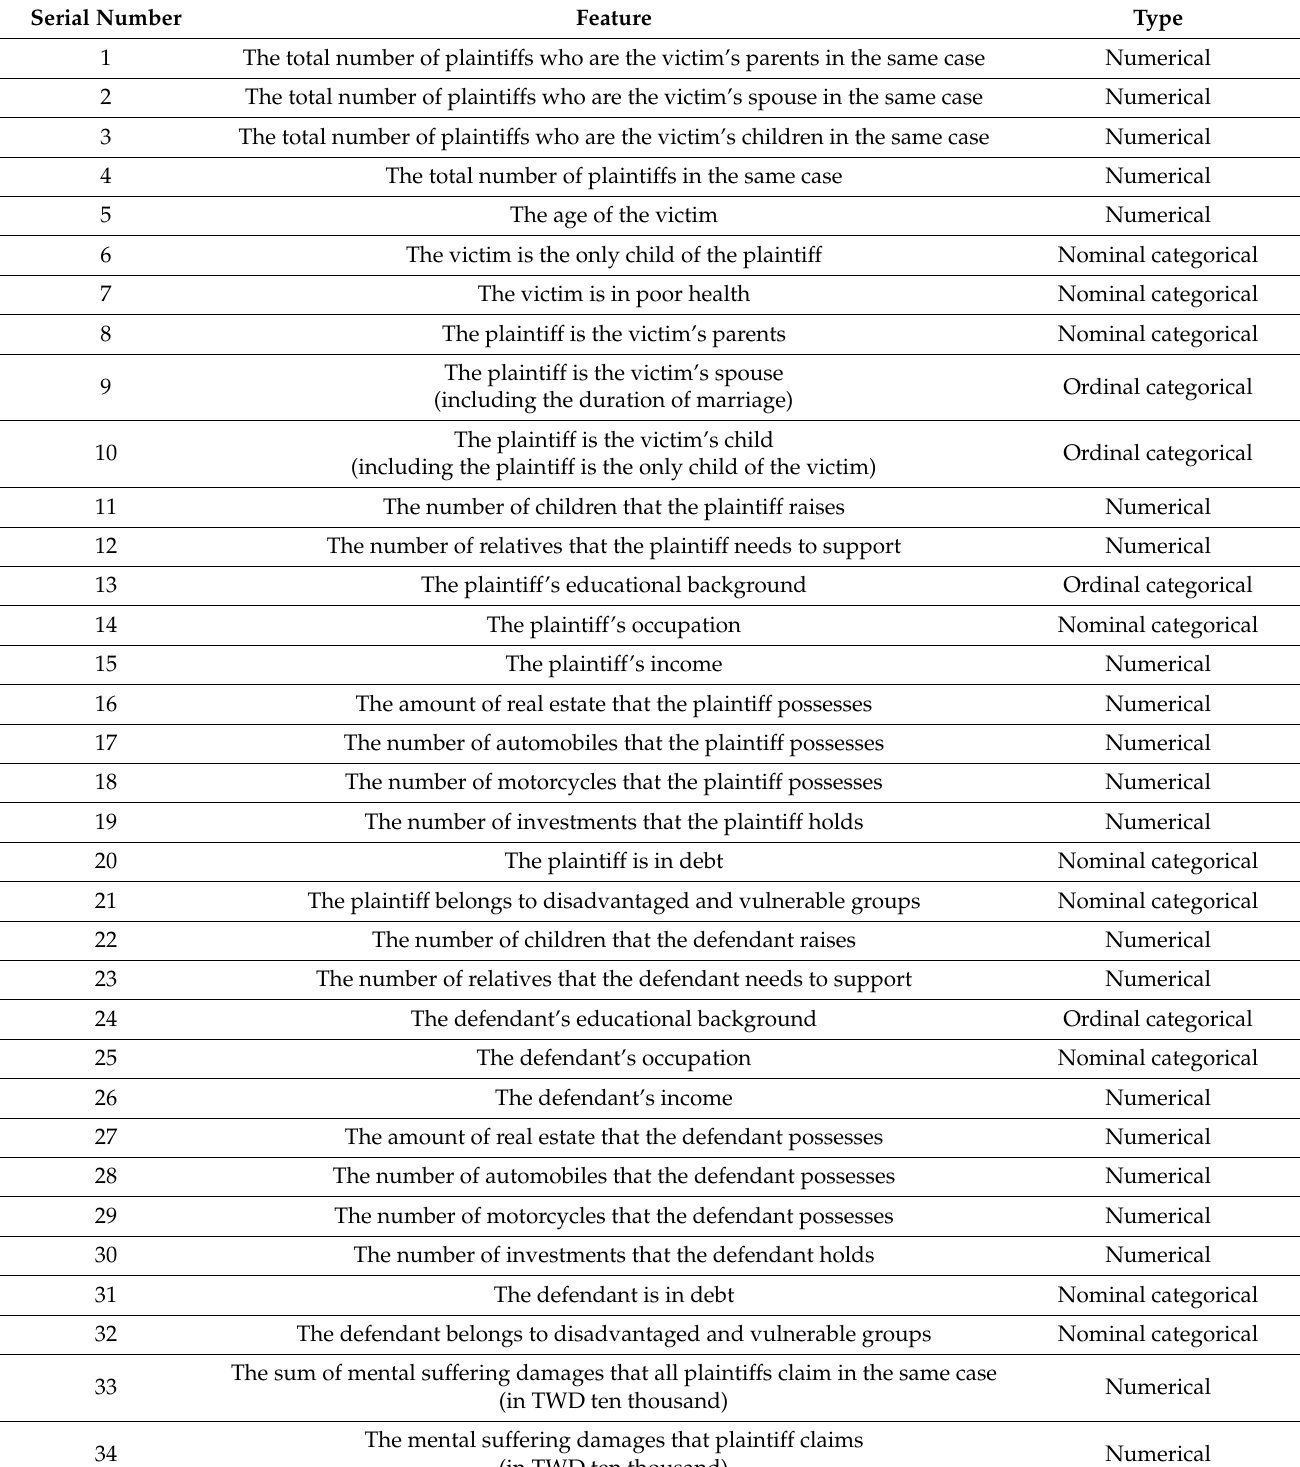
Table 1. The description of features in